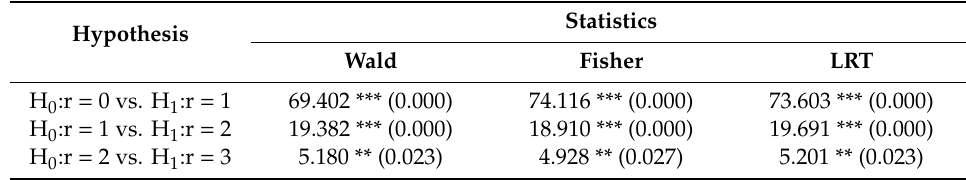
Table 2. Threshold e ff ect test of the overall model.